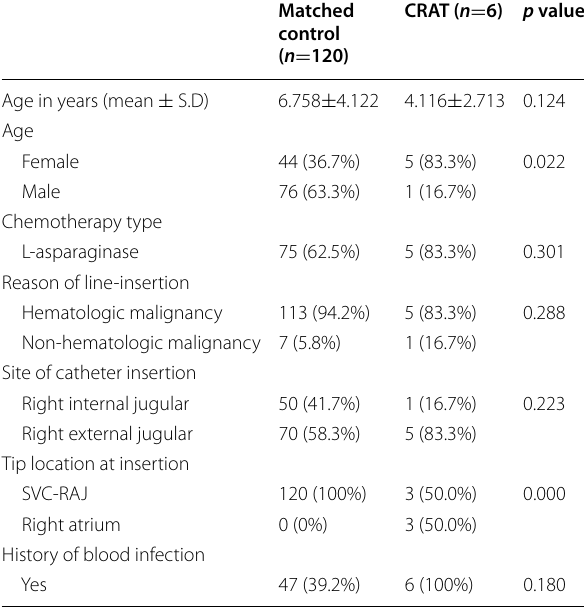
Table 1 Demographic distribution of patients